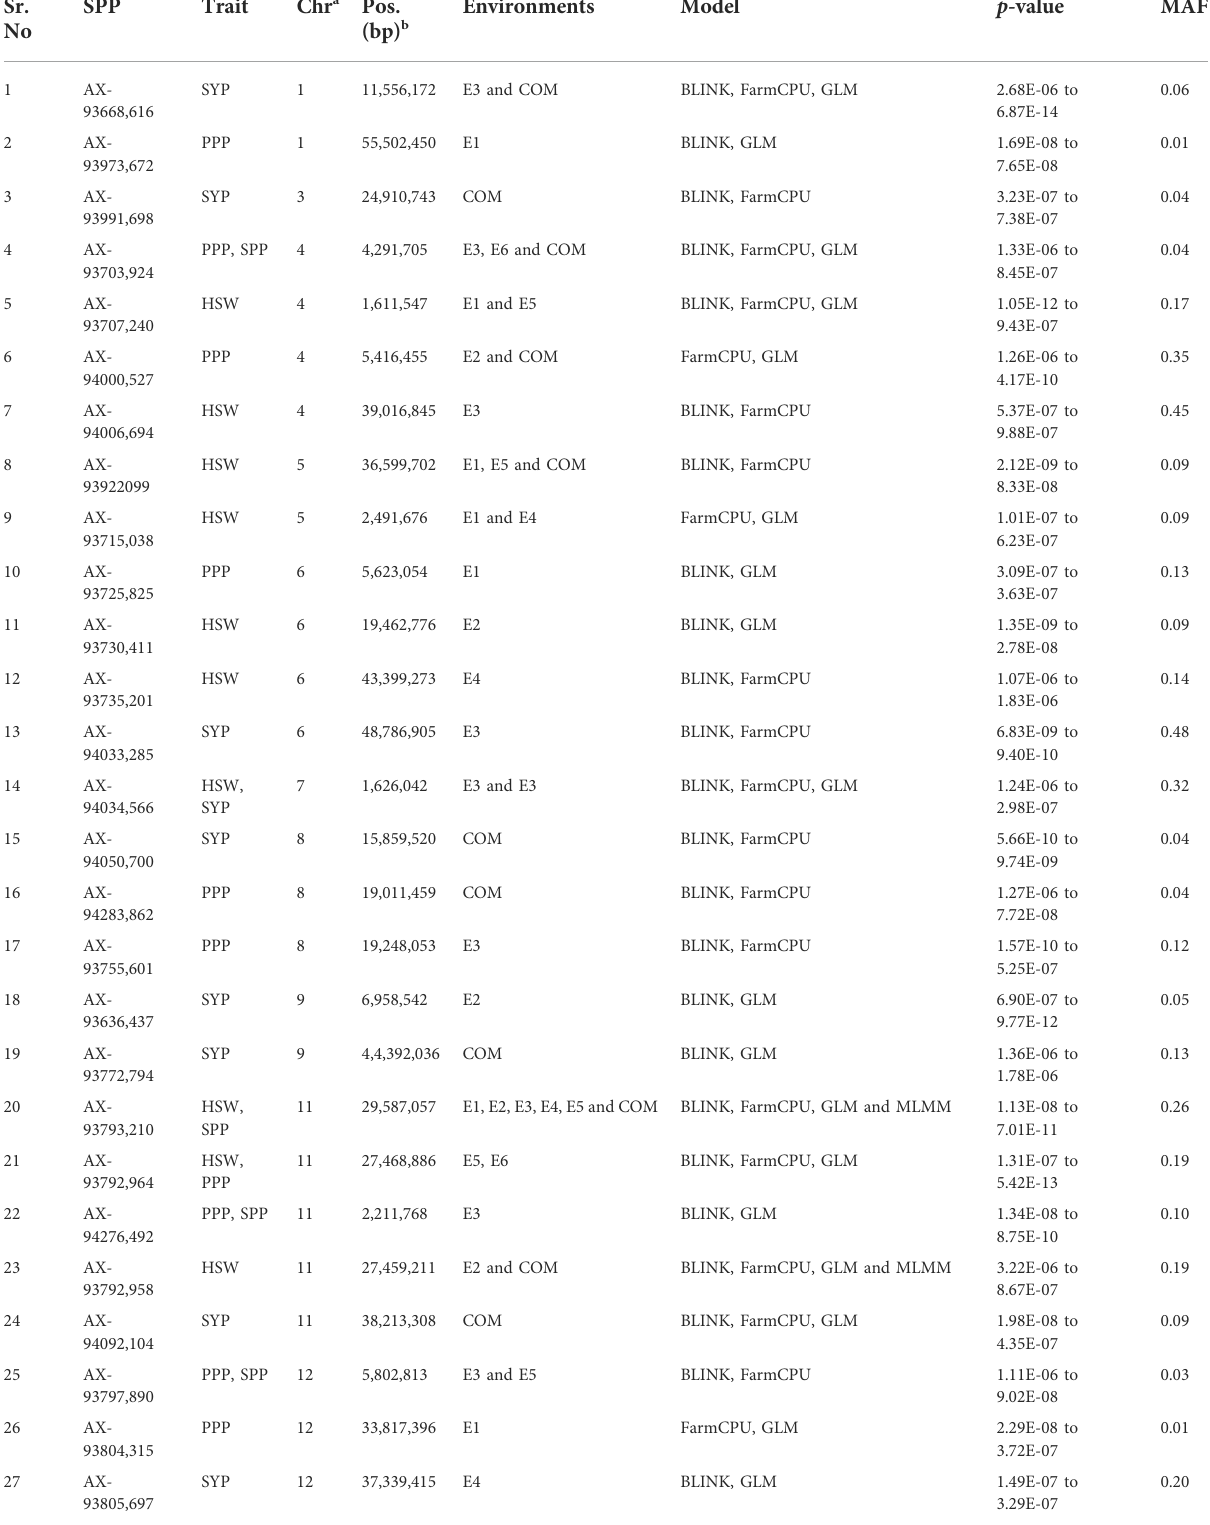
TABLE 2Signi fi cant marker-trait associationsidenti fi edfor four yieldandyield-related traits across six environments (E1, E2, E3,E4,E5, and E6) anda combined environment (COM) using fi ve GWAS models. Sr. SPP No